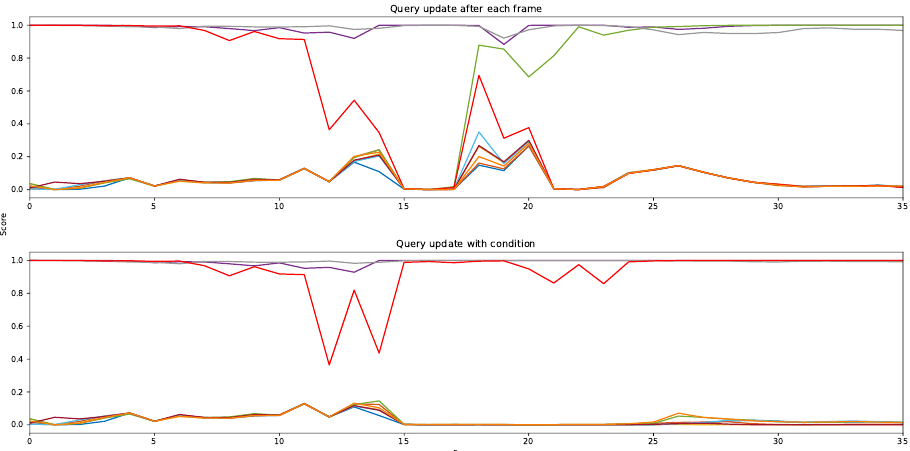
Figure 4. Prediction scores of all 10 queries at each frame of a video sequence. Different queries are represented by different